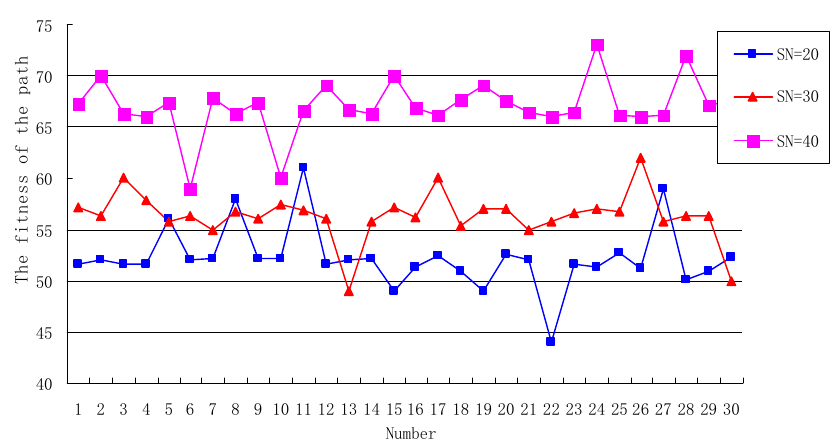
Figure 5. The fitness of the path when the SN is different.